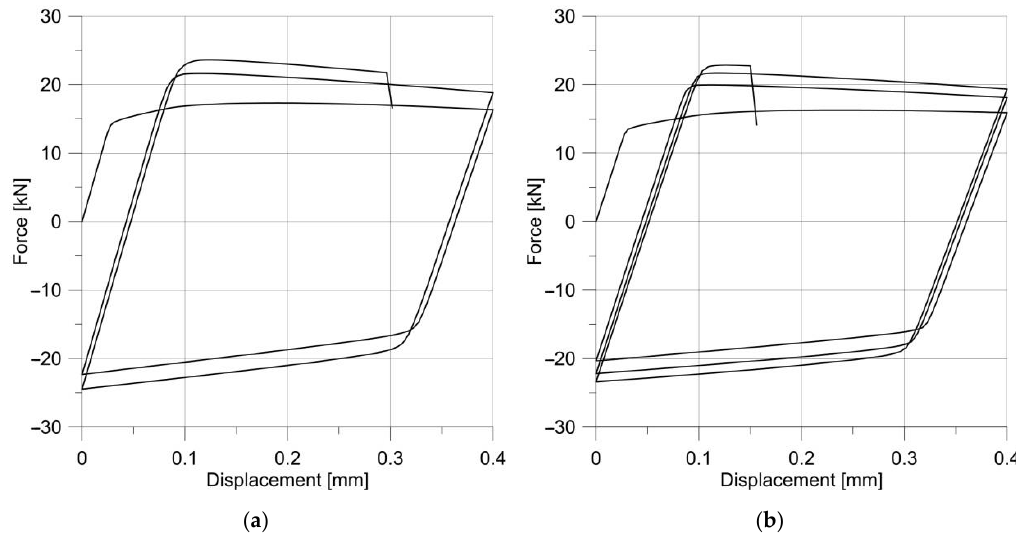
Figure 17. Changes in the stress–strain hysteresis loops for specimens with notches R = 5.0 mm ( a ) and R = 10 mm ( b ).